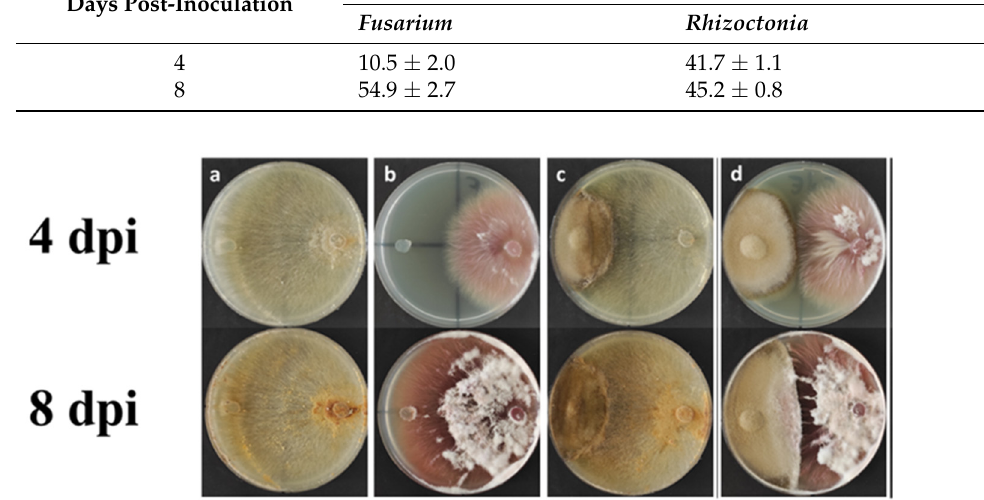
Table 3. Percentage of growth inhibition by A. tellustris against F. oxysporum and R. solani . Data show the mean ± SD of three replicas ( n = 3) at 4 and 8 days post-inoculation. % of Inhibition by A. tellustris Days Post-Inoculation Fusarium